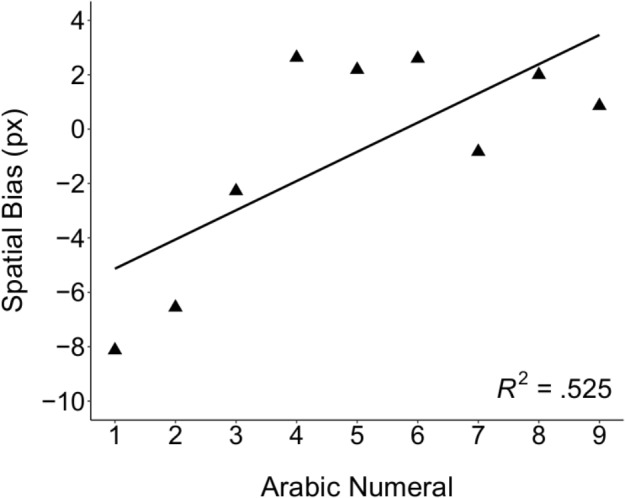
SNA on the WTN task. The mean horizontal bias, in pixels, for each number was regressed on the corresponding numerical value. Numerical value was a significant predictor of mean bias for each number, t(8) = 2.78, p < 0.05. This result provides evidence for an SNA in children, consistent with a left-to-right oriented mental number line.